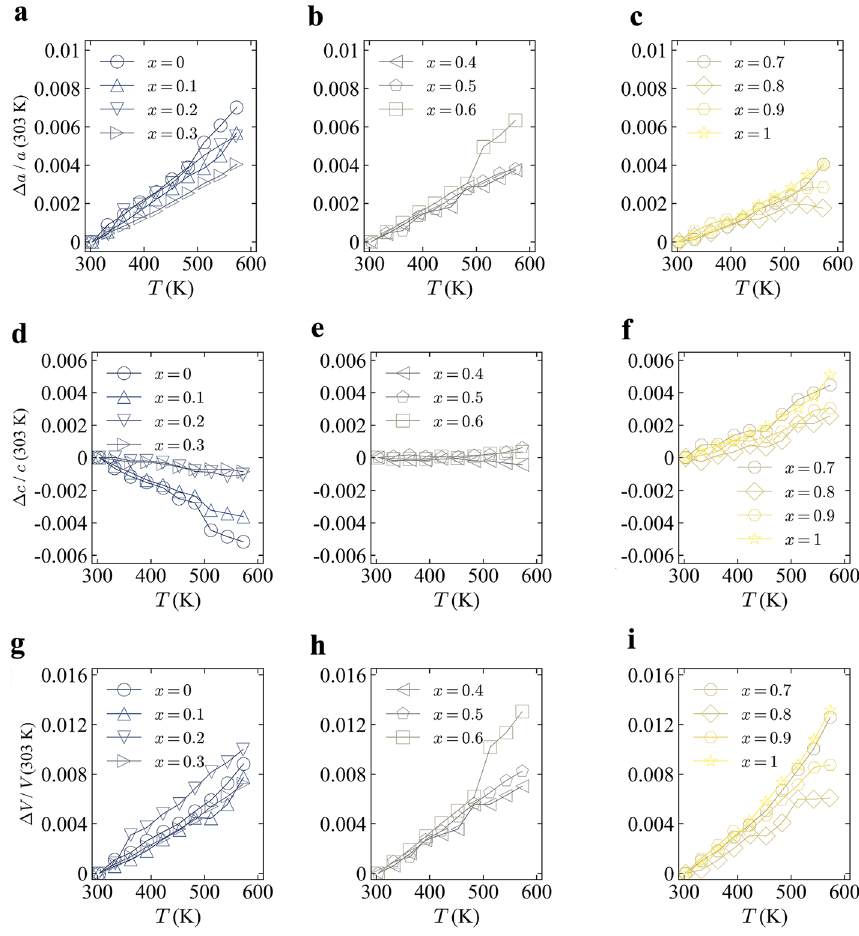
Figure 2. ( a – i ) Temperature dependence of the normalized rate of change of the lattice constants a , c , and V from 303